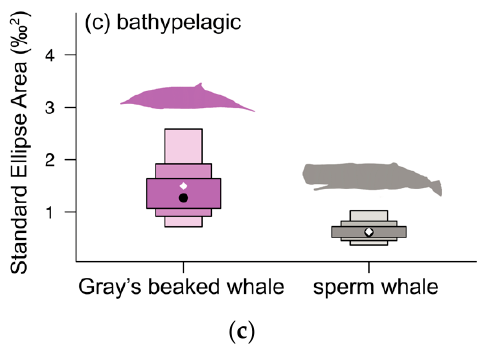
Figure 5. Density plot showing the 95, 75, and 50% credible intervals of standard ellipses area using Bayesian techniques for ( a ) neritic odontocetes: bottlenose dolphins ( Tursiops truncatus ), Hector’s dolphins ( Lagenorhynchus obscurus ), ( b ) mesopelagic odontocetes: common dolphins ( Delphinus delphis ), dusky dolphins ( Lagenorhynchus obscurus ), killer whales ( Orcinus orca ), pygmy sperm whales ( Kogia breviceps ), long-finned pilot whales ( Globicephala melas edwardii ), and striped dolphins ( Stenella coeruleoalba ), and ( c ) bathypelagic odontocetes: Gray’s beaked whales ( Mesoplodon grayi ) and sperm whales ( Physeter macrocephalus ). Black dots represent the mean standard ellipses area (SEA) for each species; white diamonds indicate the corrected standard ellipses area (SEA C ). Table 3. Isotopic niche metrics (including the six Layman metrics) for adult odontocetes with n ≥ 10. SEA = standard ellipse area, SEA C = standard ellipse area corrected for small sample size, SEA B = Bayesian SEA, TA = total area, CD = mean distance to centroid, MNND = mean nearest neighbour distance, SDNND = standard deviation of nearest neighbour distance, see supplementary material for metric definitions. The subscript ‘boot’ indicates that the value (mean) has been generated via bootstrapping. Probability refers to the probability of the respective bootstrapped metric being larger in one species over another across all draws.